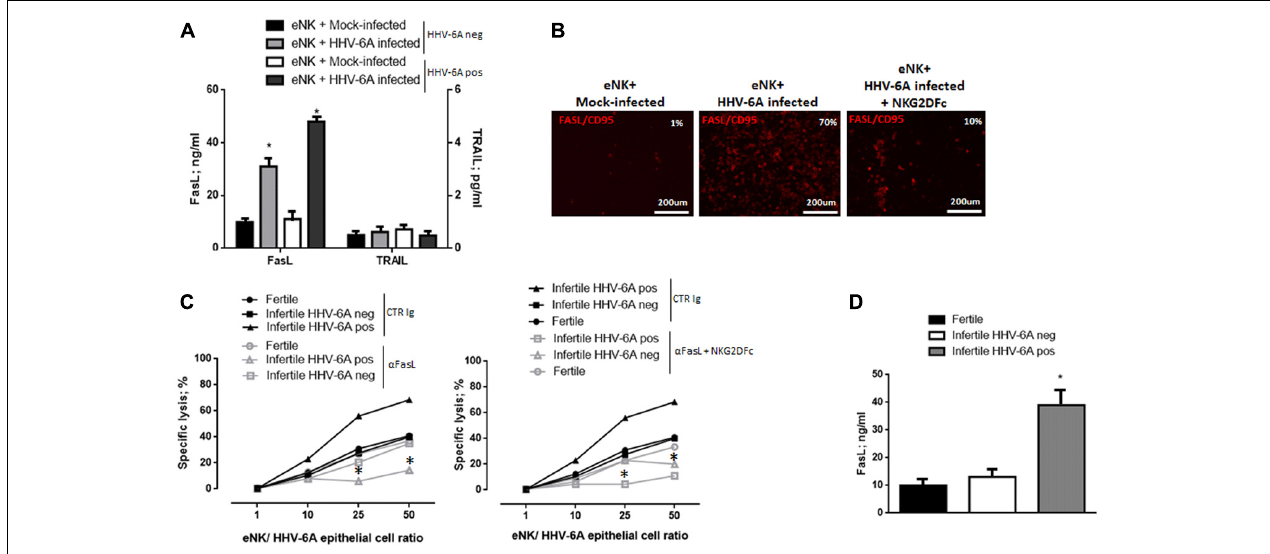
FIGURE 6 | eNK cell cytotoxicity via FasL-Fas pathway. (A) Expression of FasL and TRAIL in the culture supernatants of 18 h co-culture of HHV-6A infected endometrial epithelial cells with eNK cells from HHV-6A positive and HHV-6A negative infertile women. (B) Expression of FasL in eNK cells after 18 h co-culture with HHV-6A infected endometrial epithelial cells. Images were taken in fluorescence (Nikon Eclipse TE2000S) equipped with a digital camera. Original magnification 20 × . (C) Functional analysis of FasL. Endometrial epithelial cells were infected for 48 h with HHV-6A. eNK cell cytotoxicity was determined by 7-AAD/CFSE Cell- Mediated Cytotoxicity Assay Kit after 18 h of contact at different E/T ratios, with the addition of a control Ig (CTR Ig; black lines) or of a specific anti FasL Ig (aFasL; gray lines) (left panel) or a specific anti FasL Ig and NKG2DFc (aFasL + NKG2DFc; gray lines). Each data point is calculated as the mean lysis ± SD from at least five independent experiments done in replicate tissue culture wells. (D) Expression of FasL in the uterine flushing samples from fertile women and HHV-6A positive and HHV-6A negative infertile women. ∗ Significant p -value; Student’s t